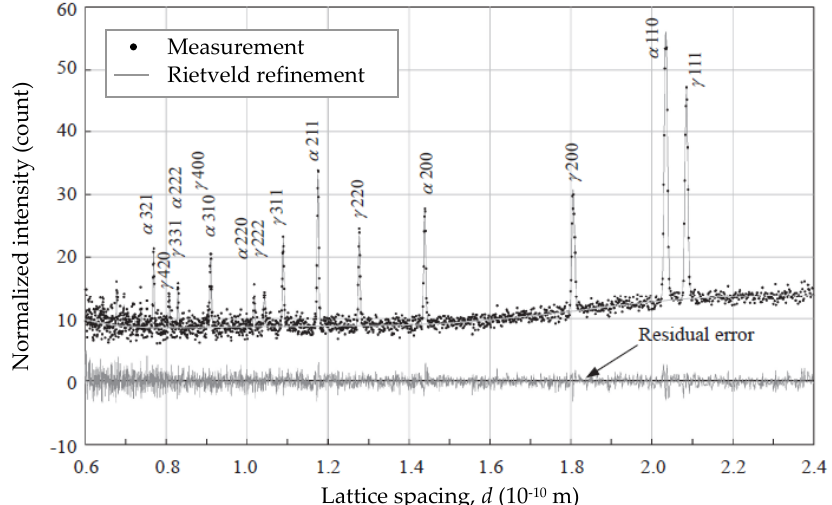
Figure 8. Neutron di ff raction intensity profile of strain-free specimen [13].